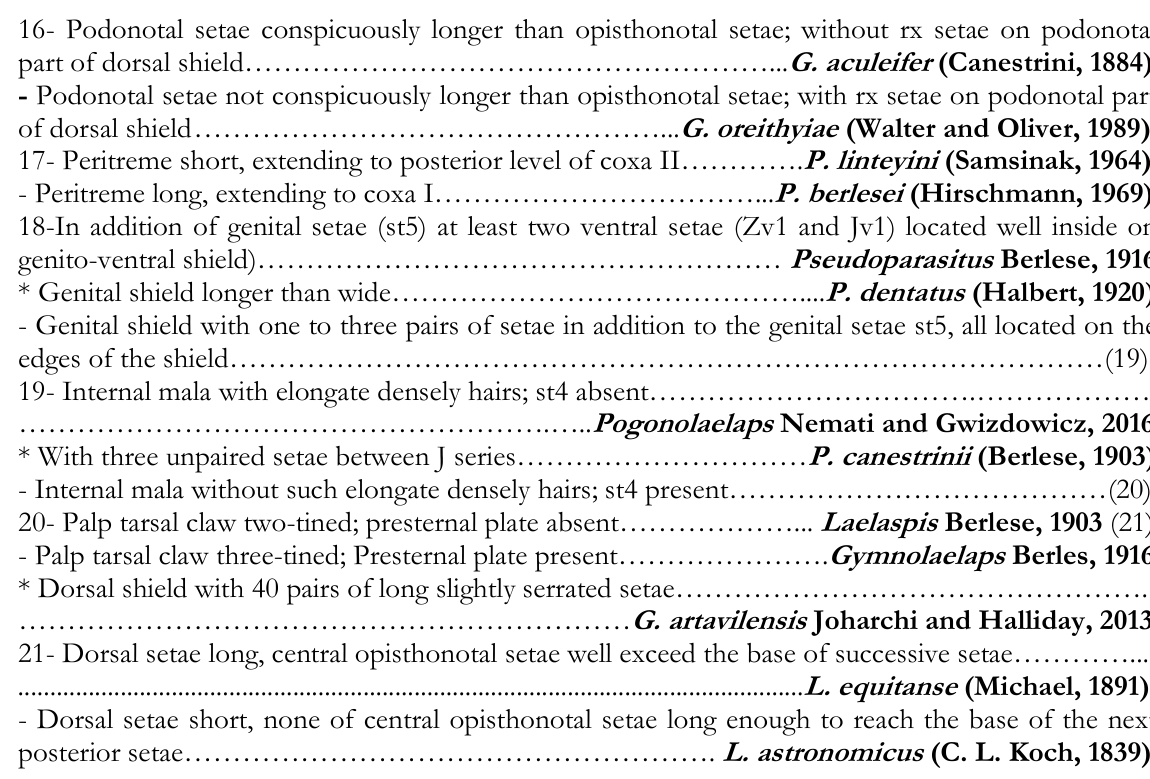
21- Dorsal setae long, central opisthonotal setae well exceed the base of successive setae…………... - Dorsal setae short, none of central opisthonotal setae long enough to reach the base of the